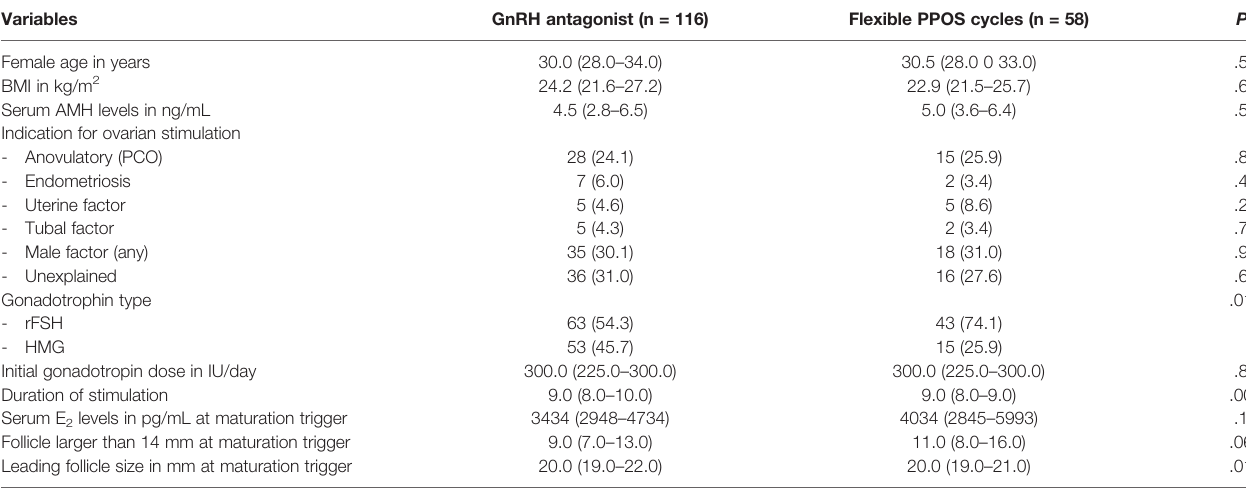
TABLE 2 | Baseline and stimulation characteristics after propensity score matching for female age and initial gonadotropin dose. Variables